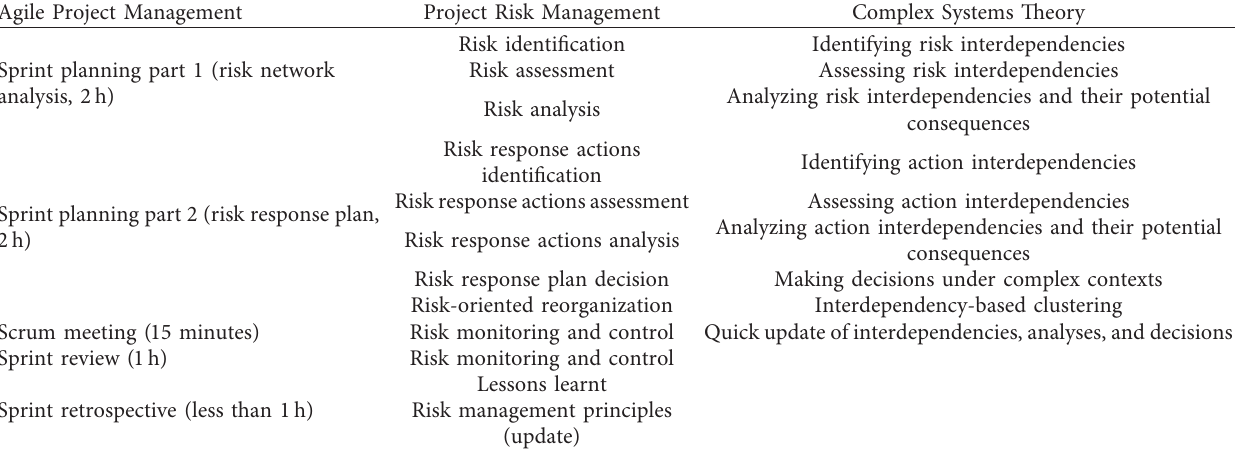
Table 2: Illustration of the correspondence between sequence of processes/steps in PRM, CST, and APM. Agile Project